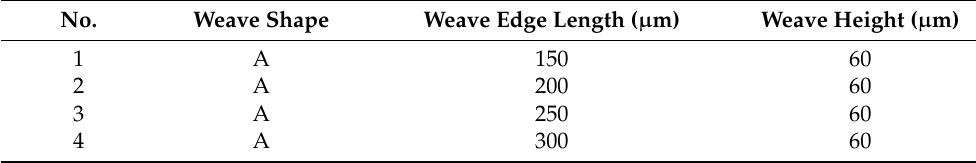
Table 7. Parameter design for experiments on the effect of weave edge